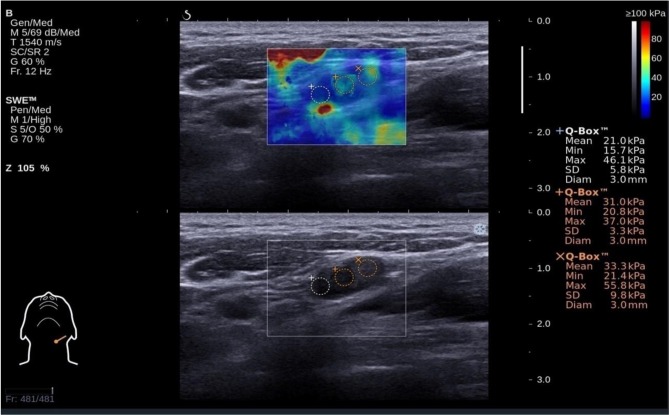
Shear wave elastography evaluation of a metastatic small cervical lymph node (sCLN) biopsy-proven: The shear wave elastography image (up) is presented simultaneously with the gray-scale ultrasound image (below) on the same screen. Shear wave elastography image revealed markedly heterogeneous color between the node lesion and surrounding tissues. The lesion was coded re-yellow. Surrounding tissues were almost pure blue in color. Emin (Minimum elasticity values) = 21.4 kPa, Emax (Maximum elasticity values) = 55.8 kPa, and Emean (Mean elasticity values) = 33.3 kPa.